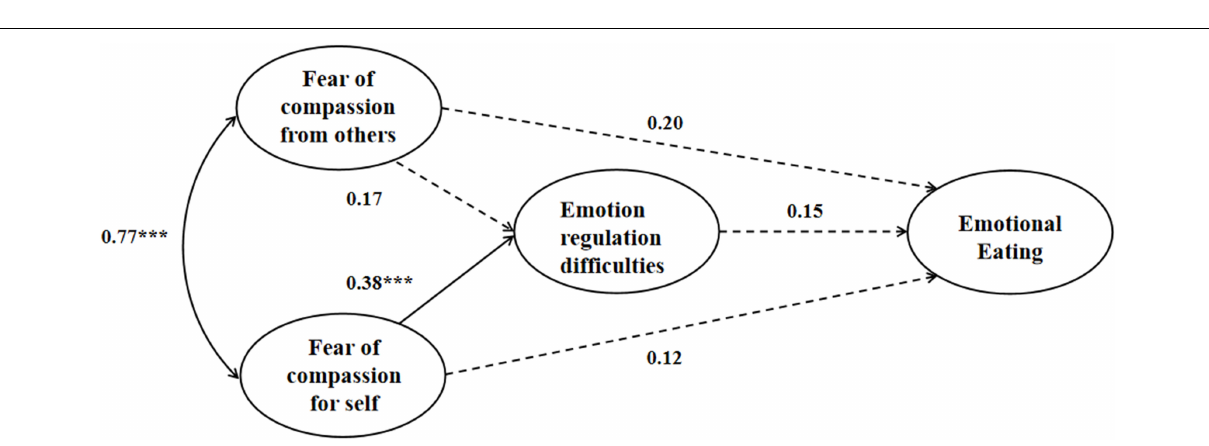
FIGURE 1 | The mediation model of the study variables for female students; standardized coefficients are presented; * p < 0.05; ** p < 0.01; *** p < 0.001.